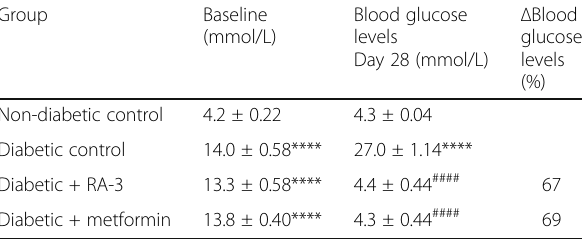
Table 1 Results of the effect of RA-3 on fasting blood glucose levels of the STZ-induced type 1 diabetic rats Group